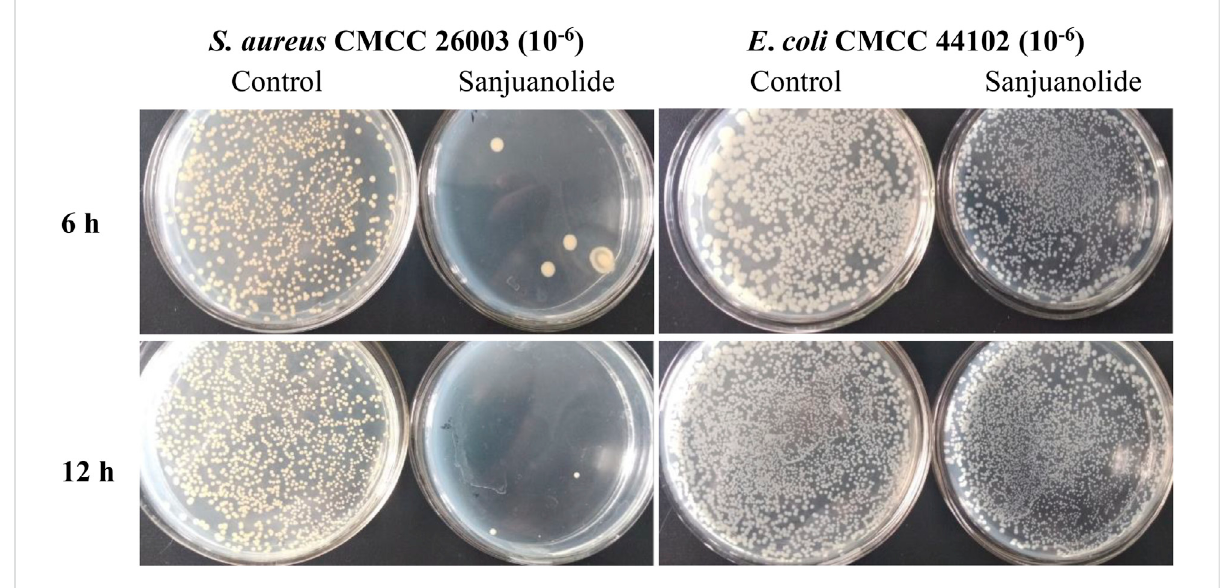
FIGURE 3 Antibacterial effect of sanjuanolide determined using the plate counting